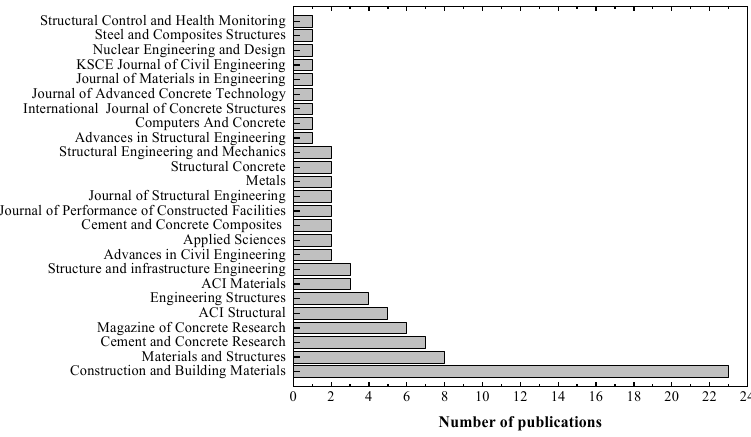
Figure 4. Distribution of articles by year of publication.